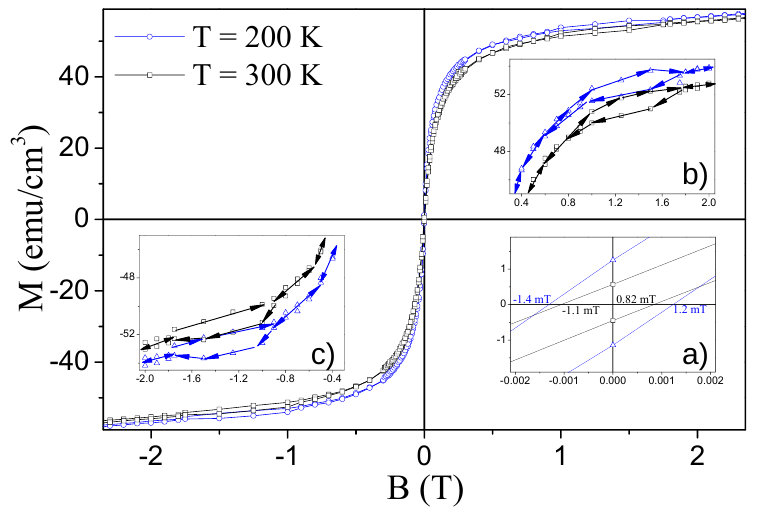
Figure 8. Magnetic field dependence of the SiO 2 (75 at.% Co)/Si sample magnetization at magnetic field from − 5 T to 5 T. Inserts: ( a )—region of the coercive fields, ( b , c )—regions of the specific hysteresis